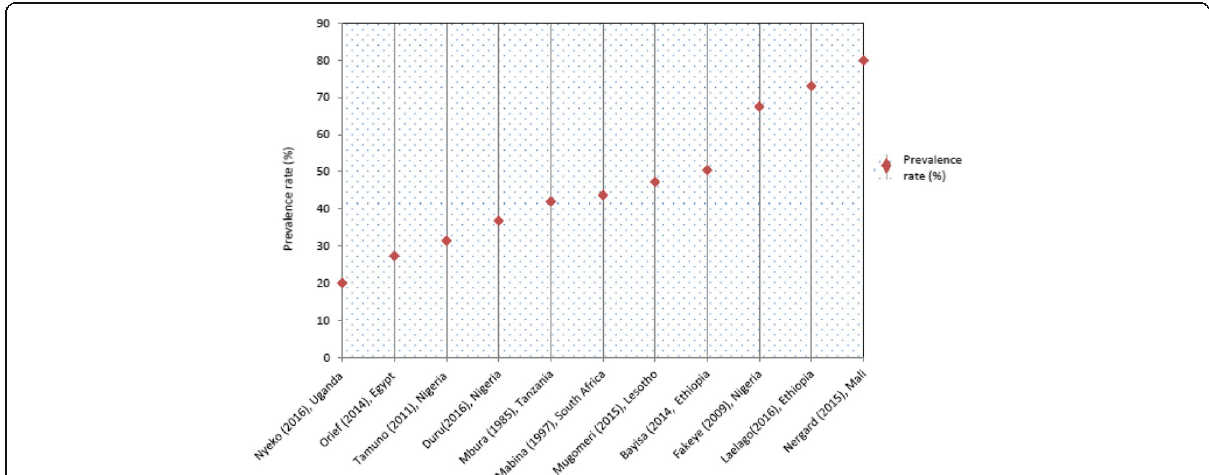
Fig. 2 Prevalence of herbal medicine use among pregnant women in